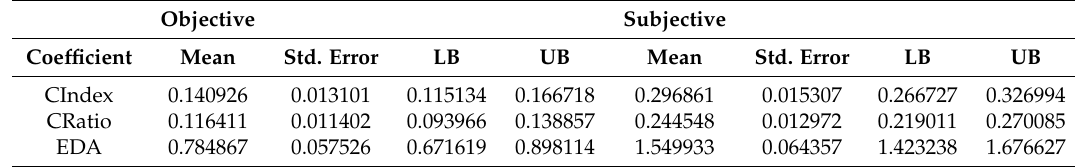
Table 4. Estimated marginal means of inconsistency coefficients for objective and subjective problem type with standard error and 95% confidence intervals.